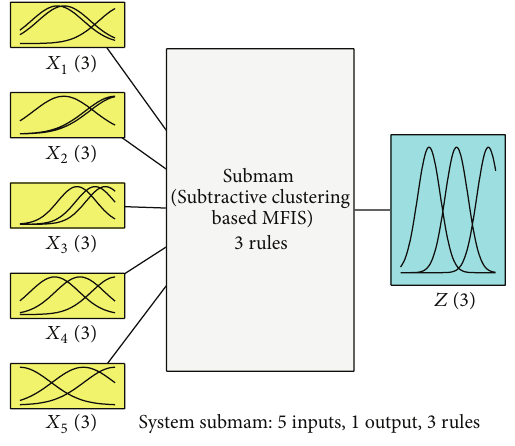
Figure 1: Mamdani